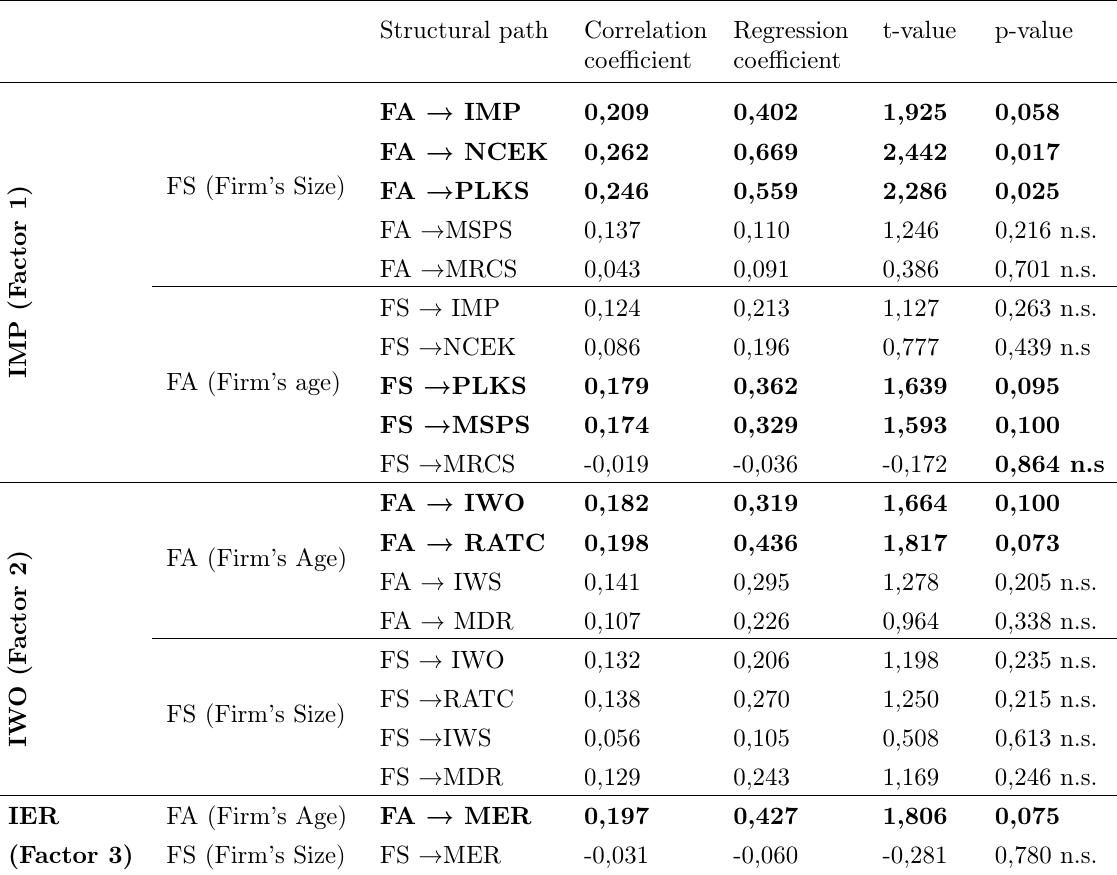
Structural path Correlation Regression coefficient coefficient